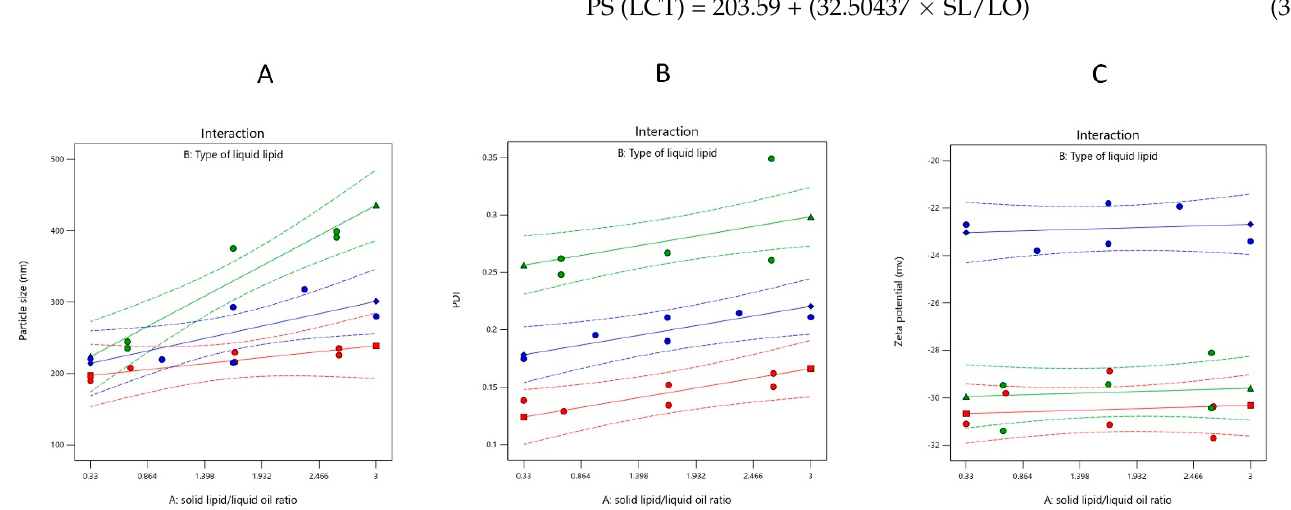
Figure 1. The effect of independent variables, solid lipid: liquid oil ratio and type of liquid oil on the measured responses ( A ) particle size, ( B ) PDI, and ( C ) zeta potential of plain NLC. Red, green, and blue colors represent the curves of a formulation containing LFCA, LCM, and LCT, respectively. Table 3. ANOVA of the quadratic model presenting the correlation ( p -value) between independent formulation variables and measured physicochemical properties (PS, PDI, and ZP).